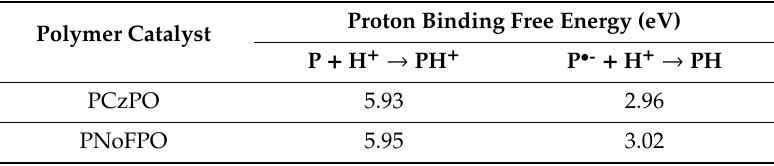
Figure 3. Schematic representation of the formation of P • - . Table 2. Proton binding free energy ( ∆ G H ) for neutral and negative PCZPO and PNoFPO D-A moieties with H bound to the O atoms of PO groups of acceptor groups, computed by density functional theory (DFT).